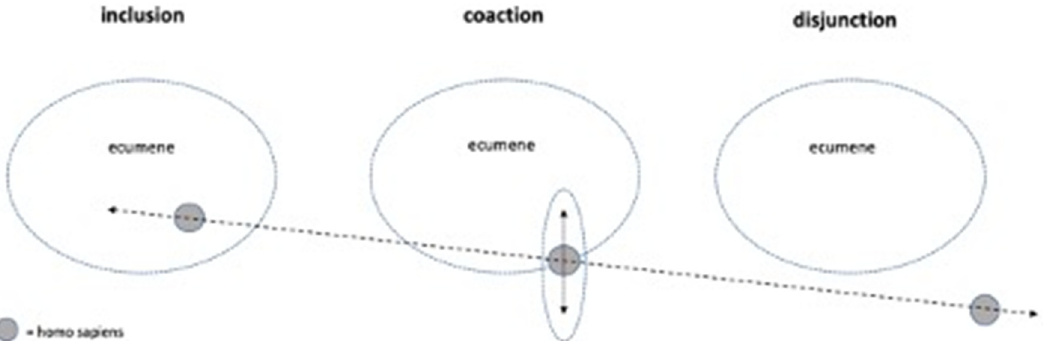
Figure 3. This figure represents the inclusive and disjunctive worldviews at the ends of an axis that situates coaction at its center. This central position represents the unique cognitive capacity of a human to position themselves in and outside of ecumene. It highlights an individual and collective capacity for change in the state of mind of being human. (Source: Author).